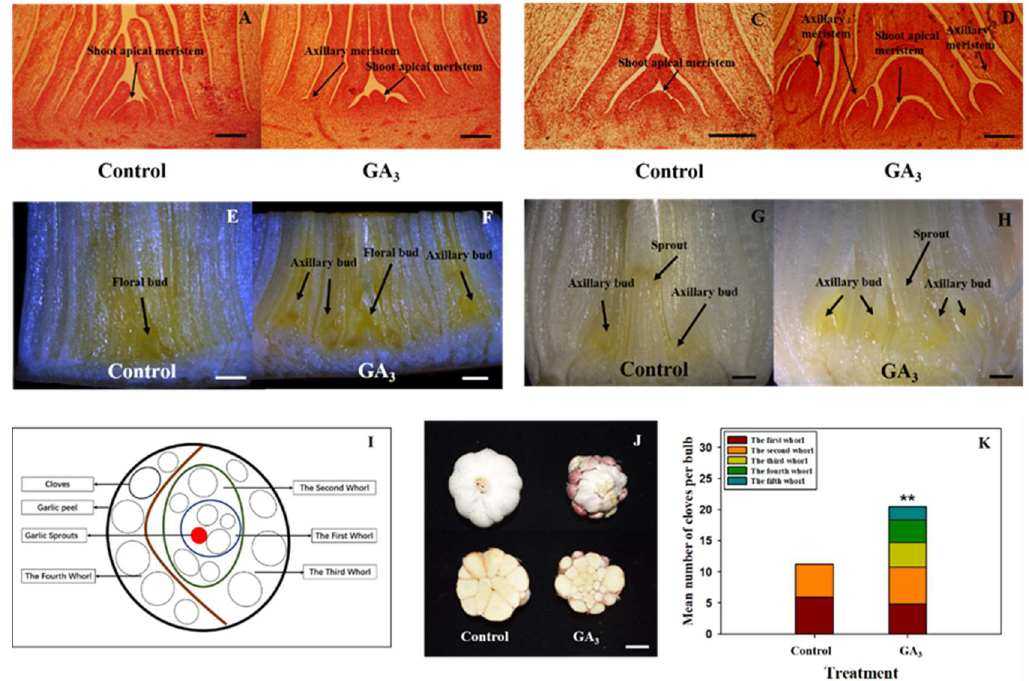
Figure 1. Histological studies on axillary meristem (bud) development in the control group and gibberellins GA 3 group. Meristem or bud development were observed at 30 ( A ), 90 ( C ), 120 ( E ) and 150 ( G ) days after water treatment. Meristem and bud development were observed at 30 ( B ), 90 ( D ), 120 ( F ) and 150 ( H ) days after GA 3 treatment. Staining solution was 1% safranin in A, B, C and D. Scale bars in A, B, C and D are 200 μm in length. Scale bars in E and F are 1 mm in length. Scale bars in G and H are 2 mm in length. After harvest, bulb structure was analyzed between control and GA 3 treatment. ( I ) A model for recording the clove number per bulb and whorl number per bulb. ( J ) Photographs showing representative bulb structure between control and GA 3 treatment. Scale bar = 1.5 cm. ( K ) Effect of injection of GA 3 on clove number and whorl number of garlic. Values are mean ( n = 10) for ( K ). Student’s t-test was used to determine significant differences between the control group and GA 3 treatment group in ( K ). Significance levels: ** p < 0.01.